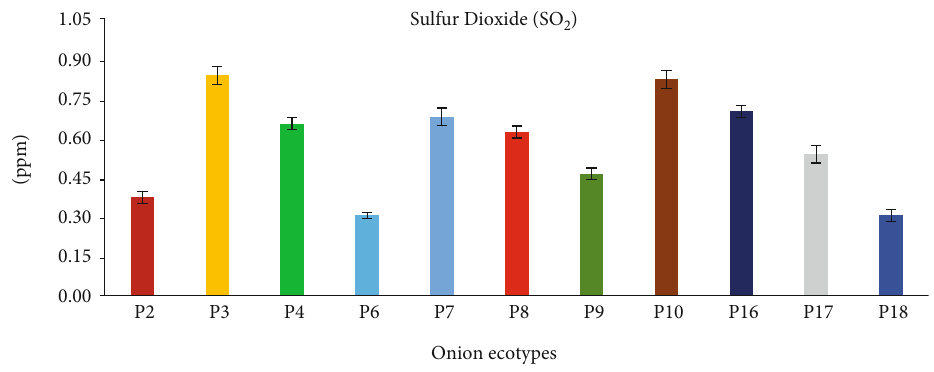
Figure 2: Sulfur dioxide content of eleven Moroccan onion ecotypes (g SO